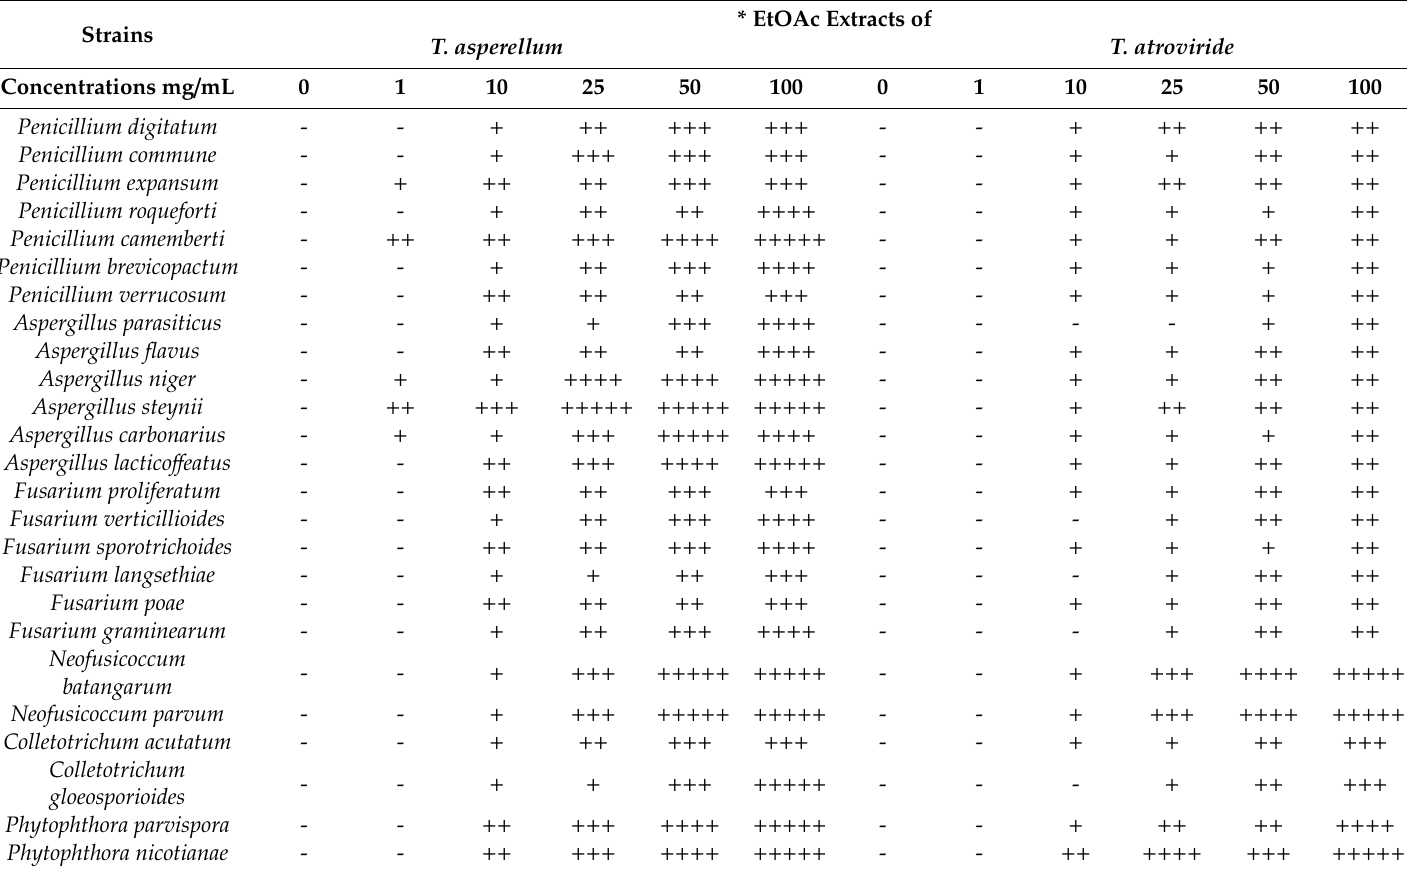
Table 1. Agar di ff usion test of 30-days EtOAc extracts. Several concentrations of the EtOAc extracts of Trichoderma asperellum IMI393899 and T . atroviride TS were tested on di ff erent pathogens; results were measured as the diameter of the inhibition halos. * Range below 5 mm (-), 5–10 mm ( + ), range 11–15 mm ( ++ ), range 16–20 mm ( +++ ), range 21–25 mm ( ++++ ), and more than 26 mm ( +++++